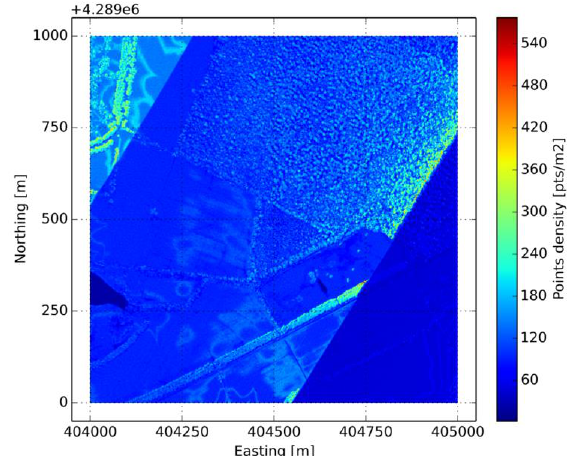
Figure 13. Sample Easton 1 x 1 km tile, showing point density in single (bottom right), dual (middle) and triple (top left) lateral overlapping flight lines.